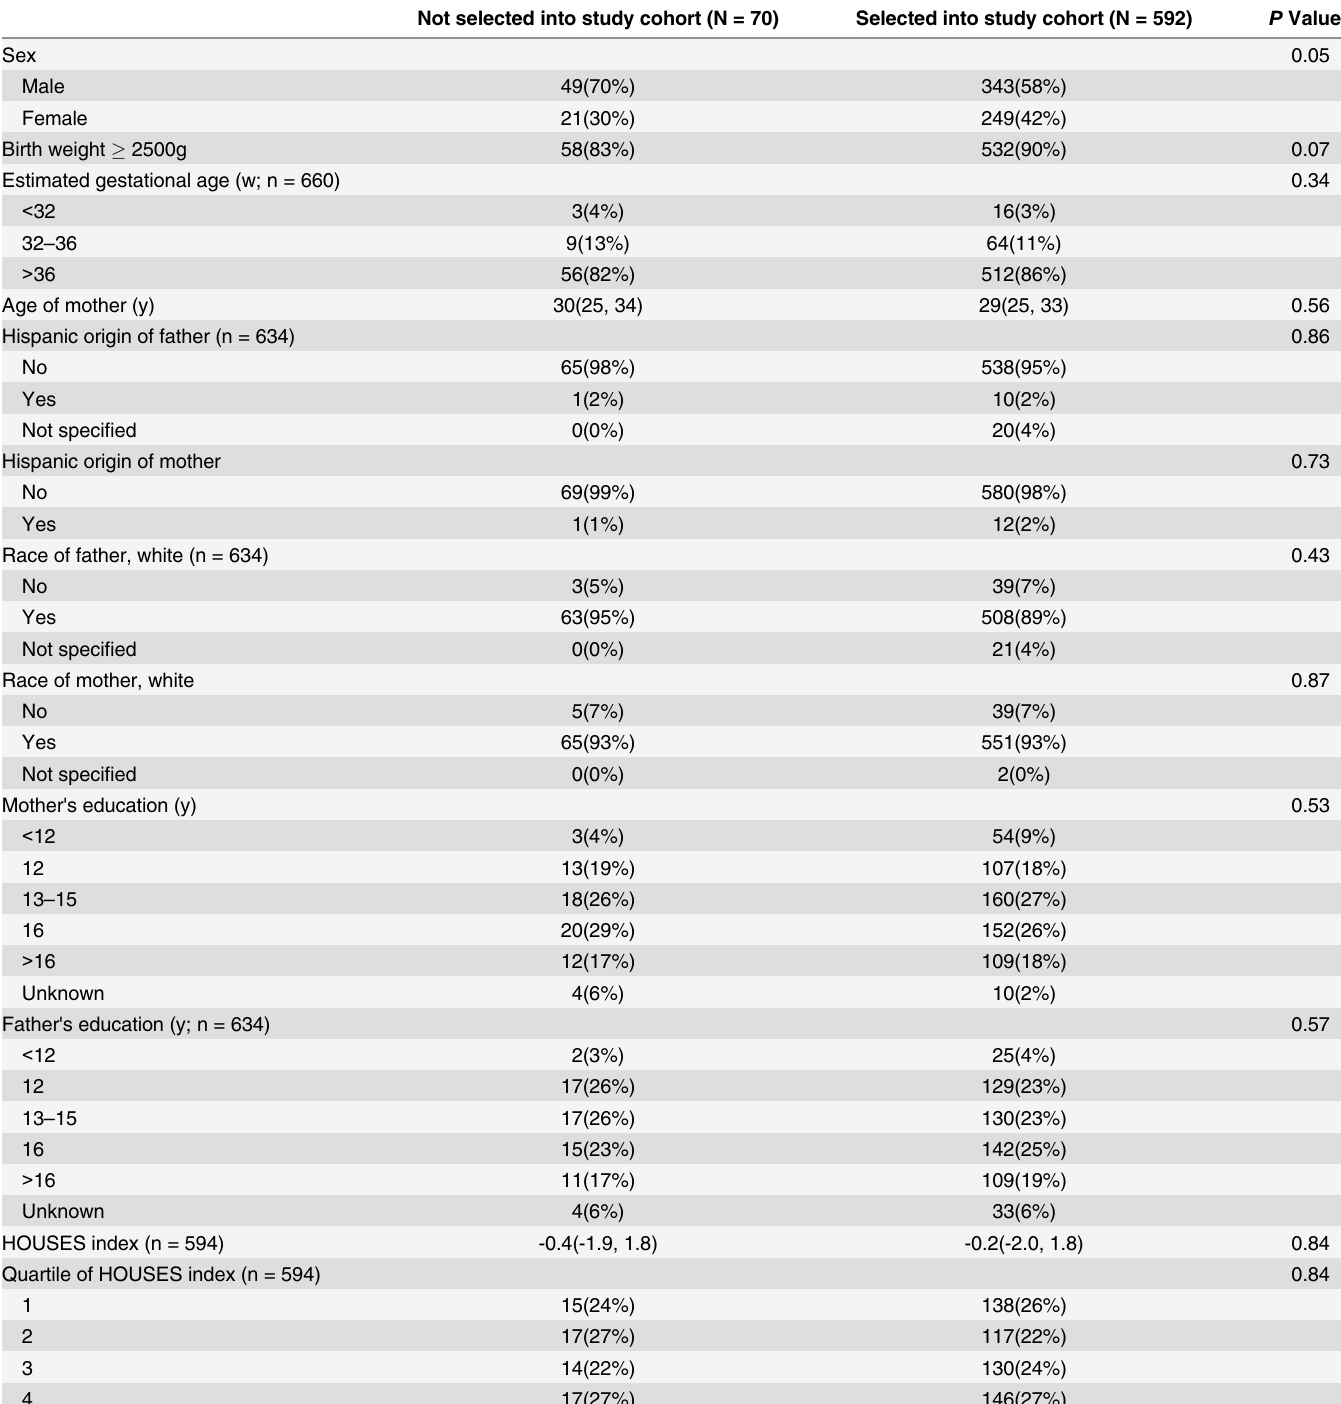
Table 3. Characteristics of children exposed to general anesthesia who were and were not selected into the study cohort (n = 662). * Not selected into study cohort (N =